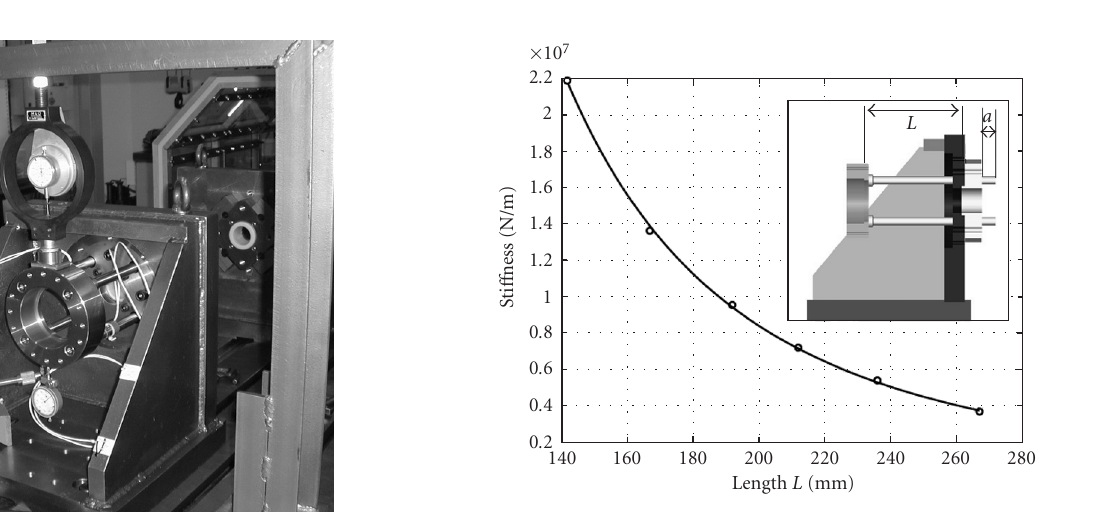
Figure 3: Details of the bearing house and flexible support assem- bly.